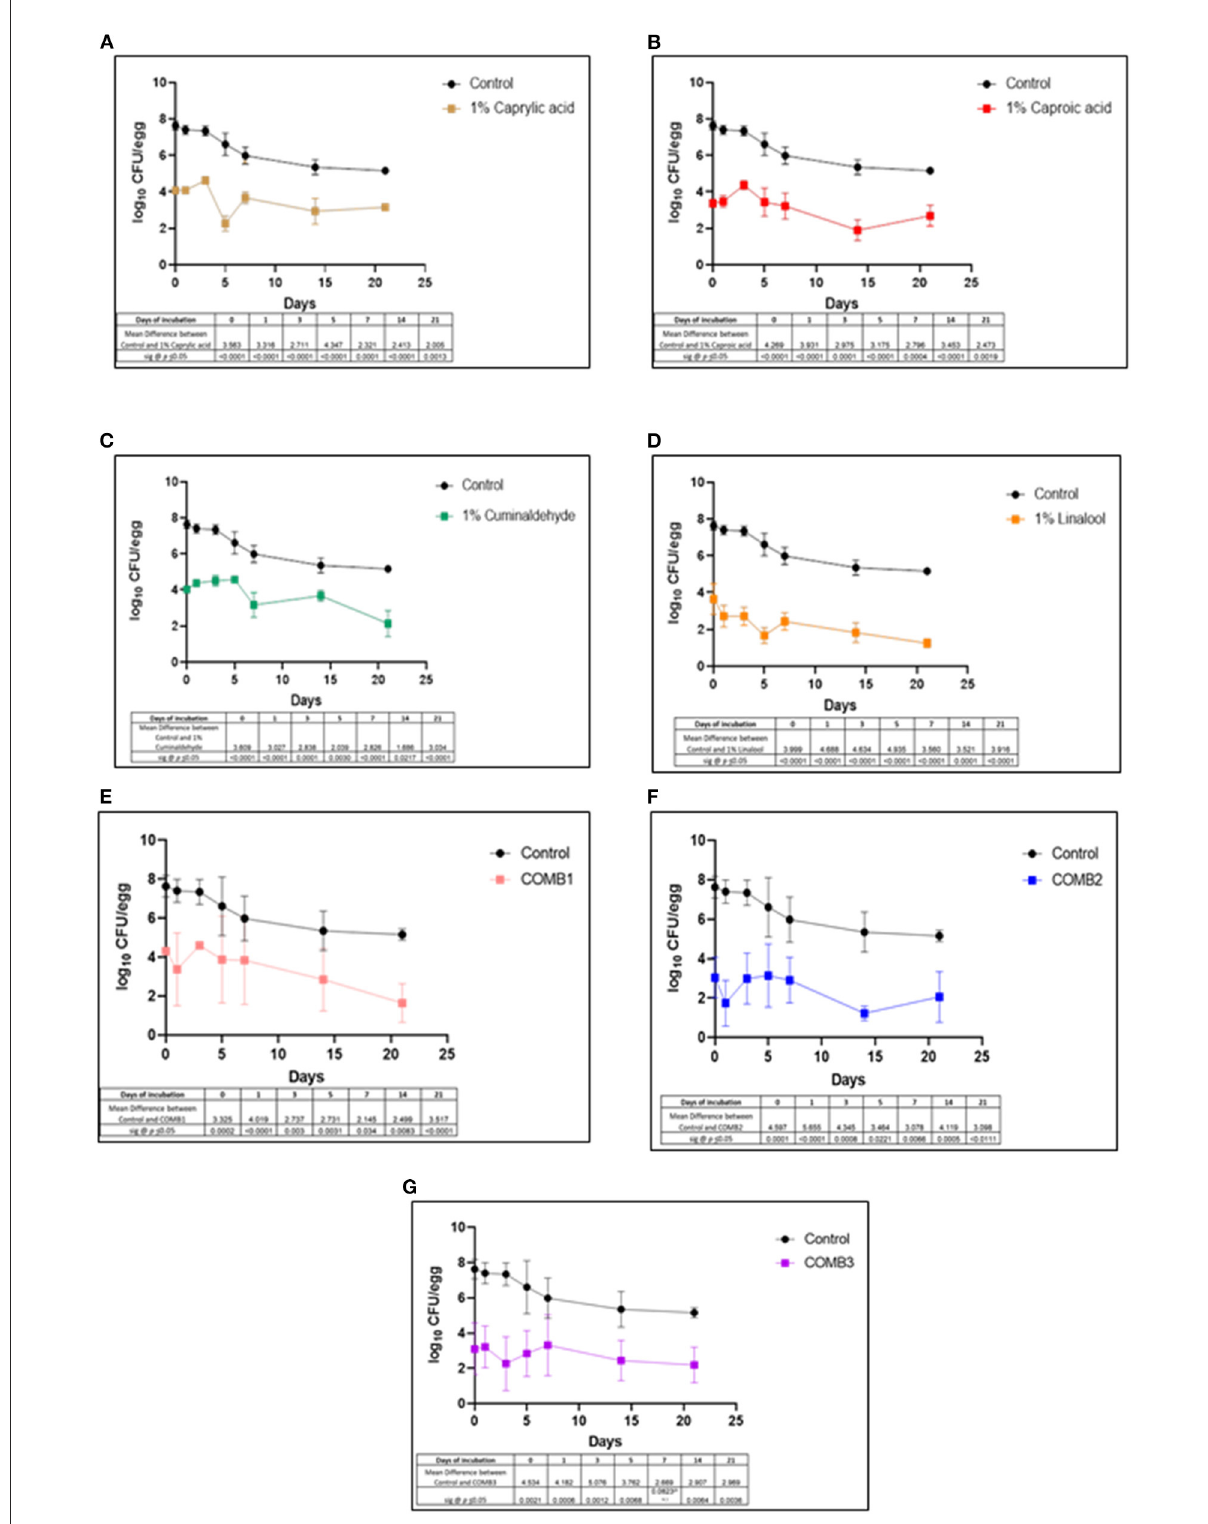
FIGURE1 Effect of (A) 1% caprylic acid, (B) 1% caproic acid, (C) 1% cuminaldehyde, (D) 1% linalool, (E) combination of 0.5% each of caprylic acid, caproic acid, and cuminaldehyde, (F) combination of 0.5% each of caprylic acid, caproic acid and linalool, and (G) combination of 0.5% each of caprylic acid, caproic acid, cuminaldehyde and linalool as pectin (2%) based coating in reducing Salmonella Heidelberg on shelled eggs. Pectin